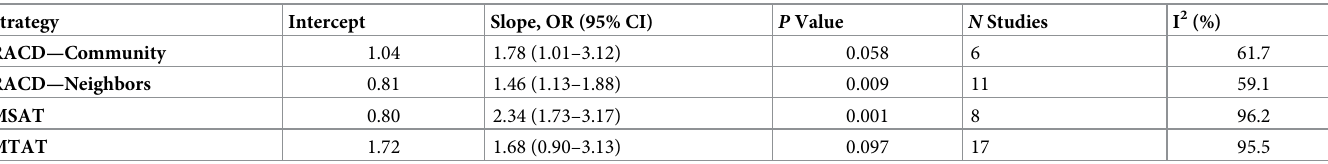
Log linear trends were estimating according to increasing OR against decreasing malaria prevalence. The results are presented on the OR scale for ease of interpretation. PCR method or continental region didn’t have an impact on the estimates, but sample sizes were too small to assess this formally. Results suggest an increase in OR or malaria infections clustering as PCR prevalence decreases across all strategies. The number of studies included in the pooled analysis as well as the assessment of heterogeneity within the strata (I 2 ) are also